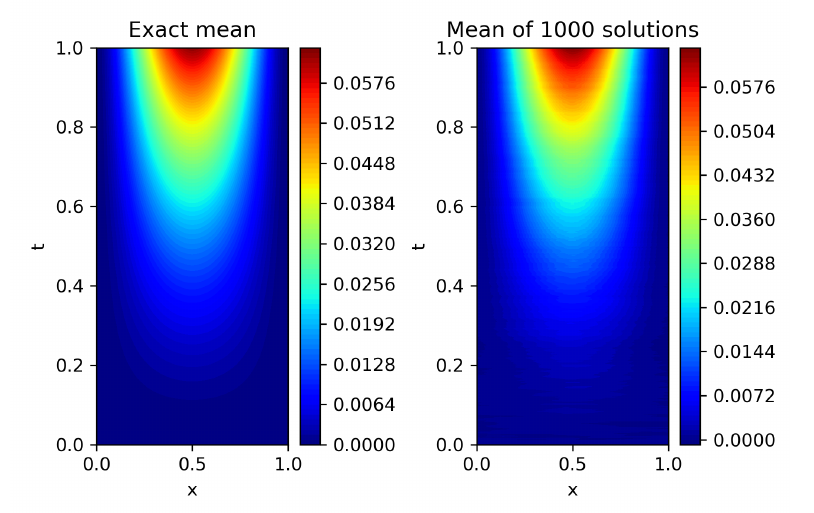
Figure A1. Solution to forward problem: Exact mean ( left ) and computed mean ( right ) of 1000 solu- tions under 1000 realizations of white